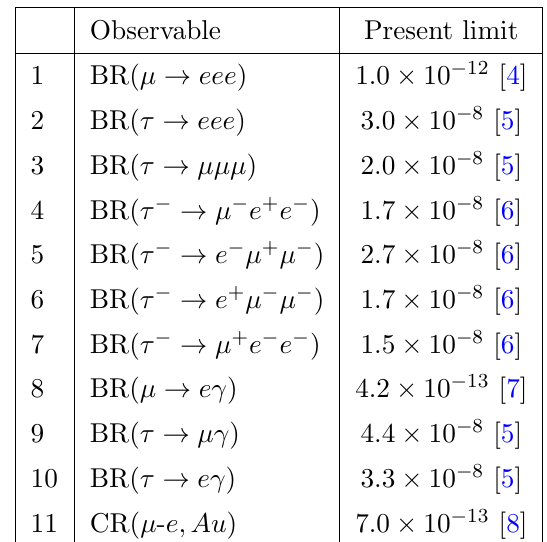
Table 1 . Our U(1) charge assignment for the SM (cid:12)elds and the (cid:13)avon.